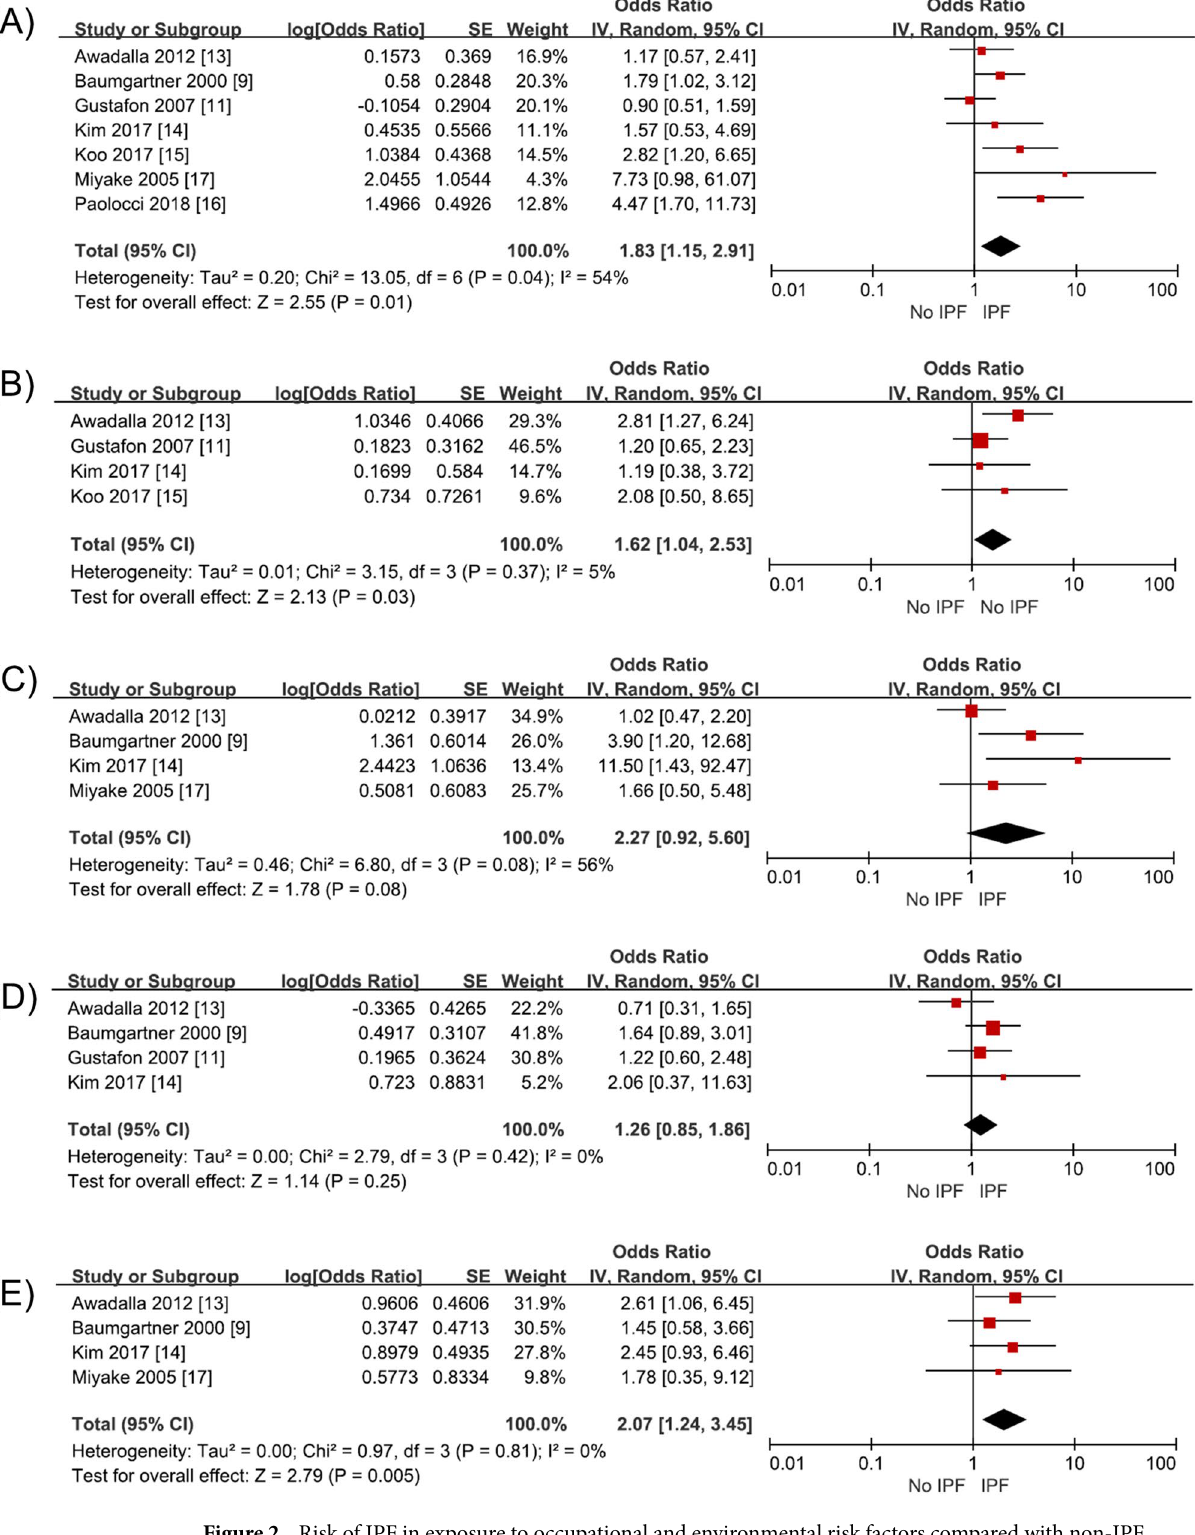
Figure 2. Risk of IPF in exposure to occupational and environmental risk factors compared with non-IPF subjects. ( A ) metal dust, ( B ) wood dust, ( C ) stone and sand dust, ( D ) textile dust, and ( E )